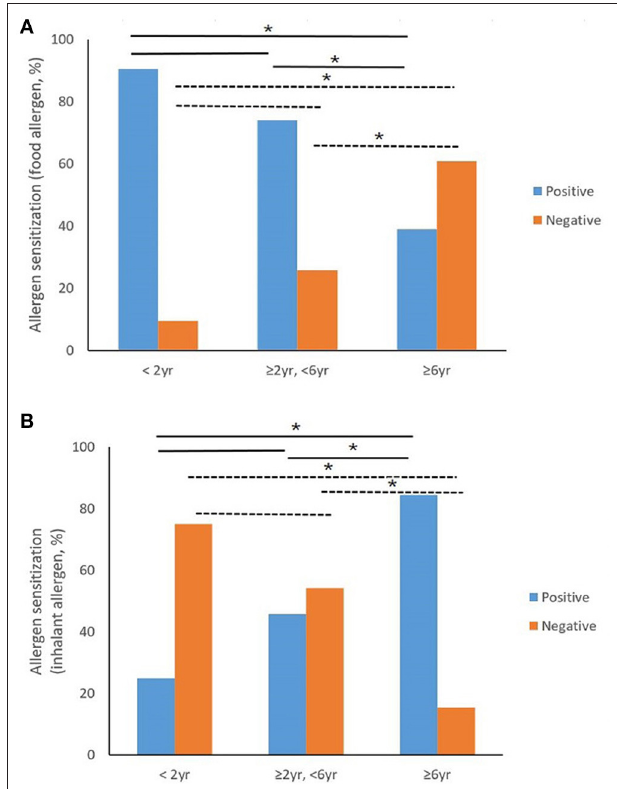
FIGURE 1 | Trend of allergic sensitization by age group of children with anaphylaxis. (A) Shows the relationship between food allergen sensitization and age group. Food allergen sensitization rates were significantly different among the age groups ( P = 0.001). With the Bonferroni correction, the food sensitization rate of the group aged over 6 years is significantly lower than that of other age groups. (B) Shows the relationship between inhalant allergen sensitization and age group. Inhalant allergen sensitization rates were significantly different among the age groups ( P = 0.001). With the Bonferroni correction, the inhalant sensitization rate of the group over 6 years old was significantly higher than that of other age groups (* P <